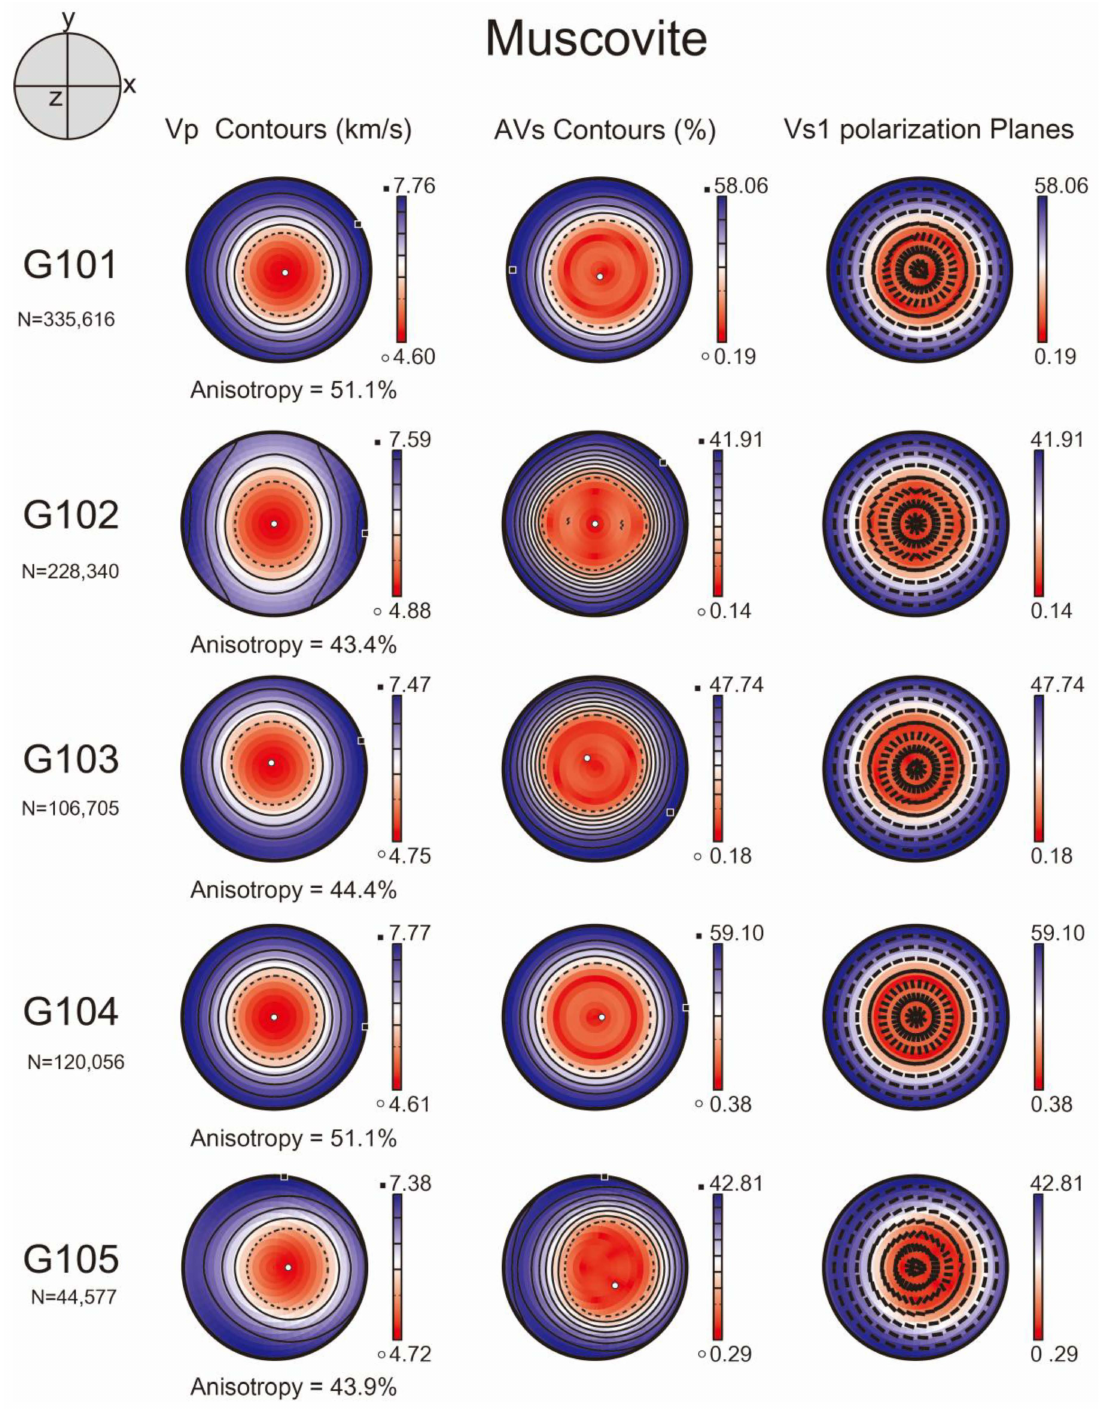
Figure 6. Seismic properties of muscovite calculated from lattice preferred orientation (LPO) and elastic constant. The P-wave velocity (Vp), amplitude of the shear-wave anisotropy (AVs), and polarization direction of the faster shear wave (Vs1) are plotted in the lower hemisphere using an equal-area projection. E–W direction of each figure corresponds to stretching lineation (X), and Z is normal to the foliation. N = number of data